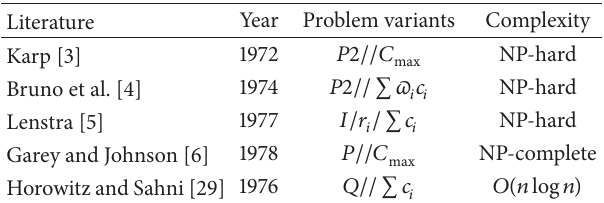
Table 1: The complexity research of various parallel machine problems in the